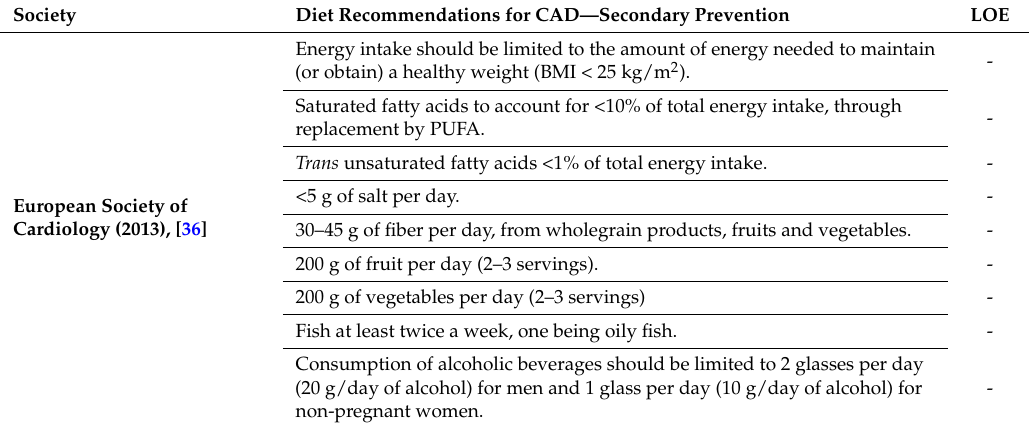
Table 4. ESC and ACC/AHA dietary recommendations for secondary prevention of